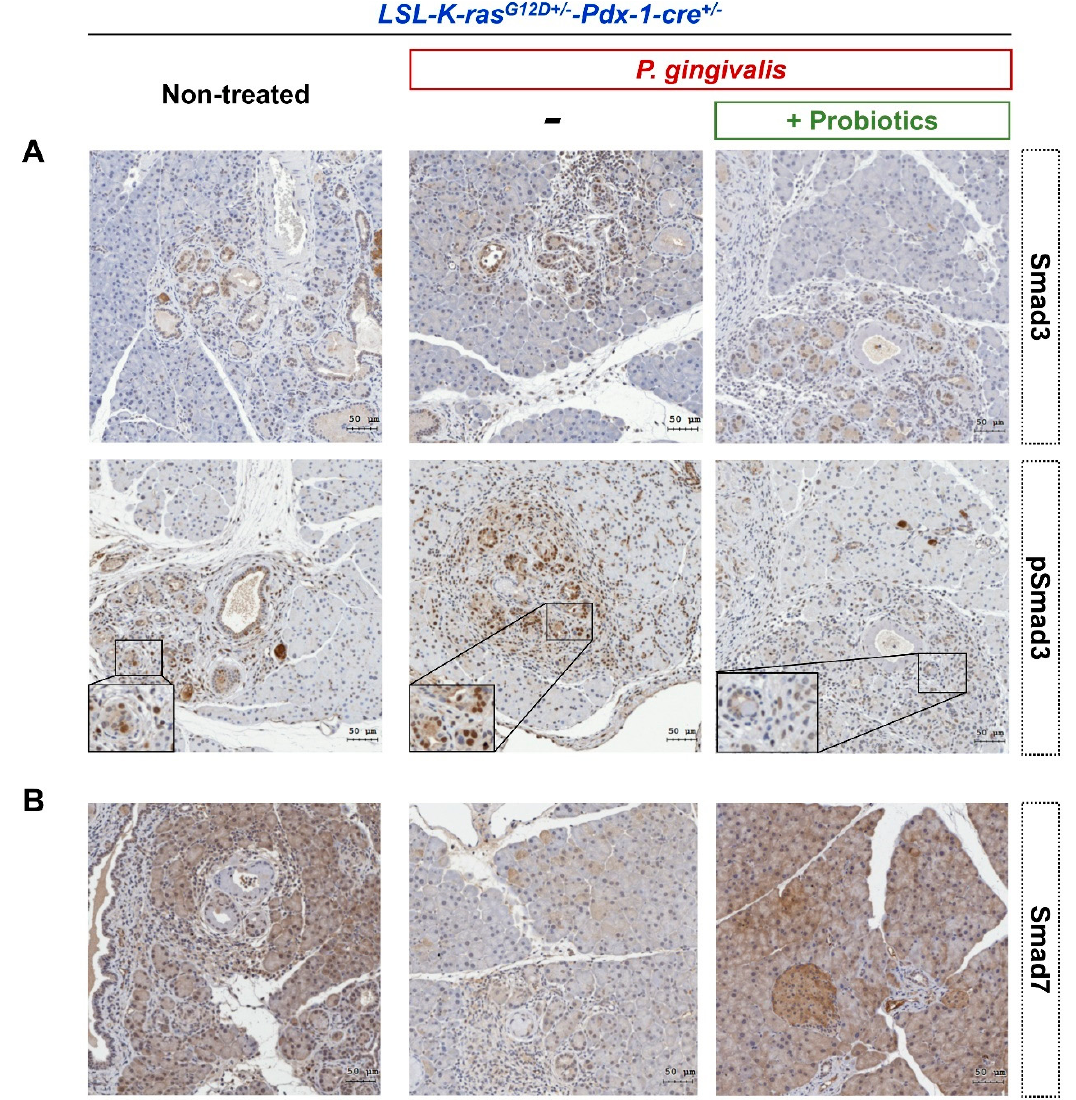
Figure 7. Representative expression of TGF- β signaling pathway-related proteins in pancreatic tissues by immunohistochemistry analysis in non-treated KC mice, P. gingivalis -treated KC mice, and P. gingivalis plus probiotic-treated KC mice (GMNL 89: GMNL133 in 1:1 ratio). ( A ) Smad3 and phospho-Smad3 staining. ( B ) Smad7 staining (scale bar, 50 µm). KC, LSL-K-ras G12D+/- - Pdx-1-cre +/- .